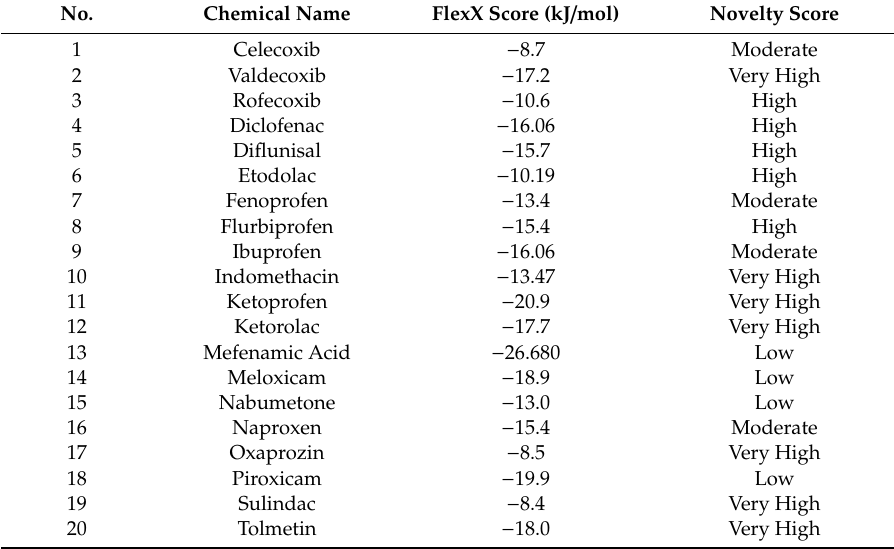
Table 2. Food and Drug Administration (FDA)-approved nonsteroidal anti-inflammatory drugs (NSAIDs) along with FlexX scores provided by the FlexX algorithm and novelty scores calculated using the Activity Atlas model.